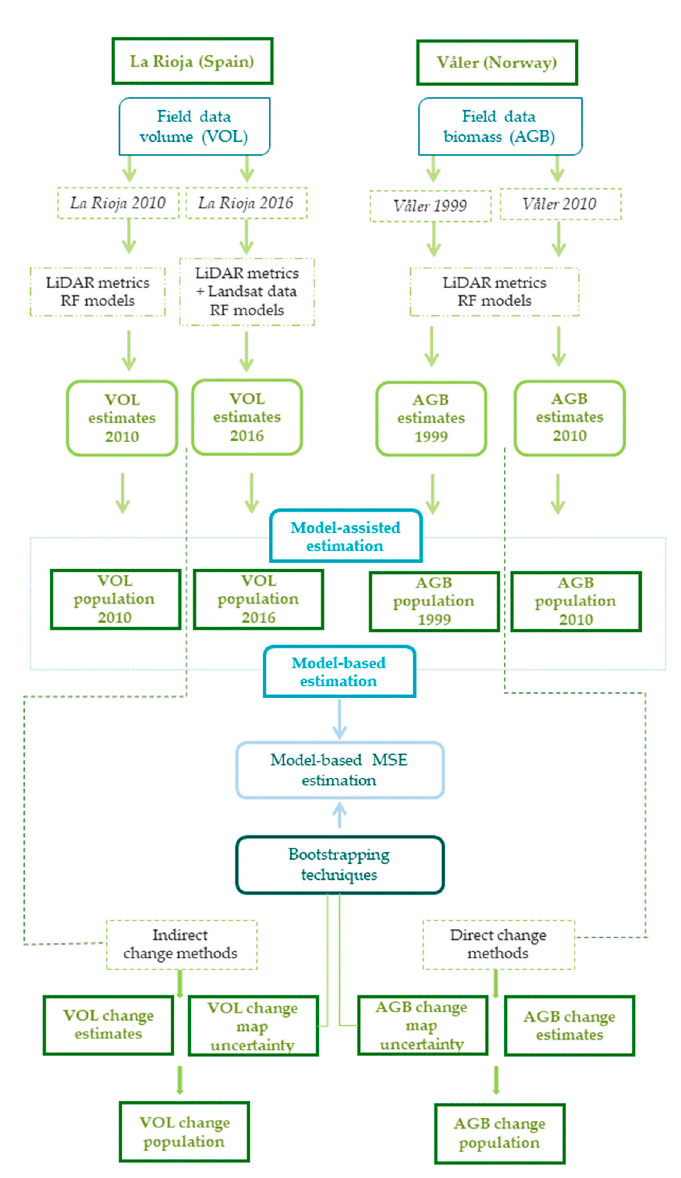
Figure 2. General methodology workflow used for estimating volume and biomass per unit area as well as the changes in these forest attributes using random forests and remotely sensed data. Note: MSE: Mean square error.